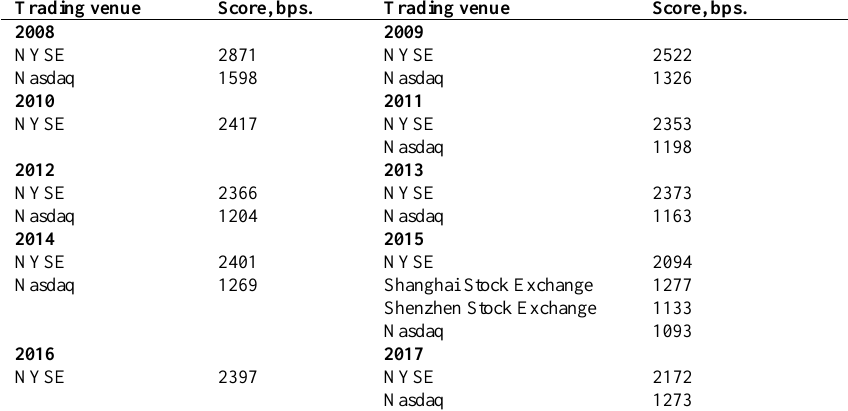
Table 5. Global systemically important trading venues for the “size” category Trading venue Score,